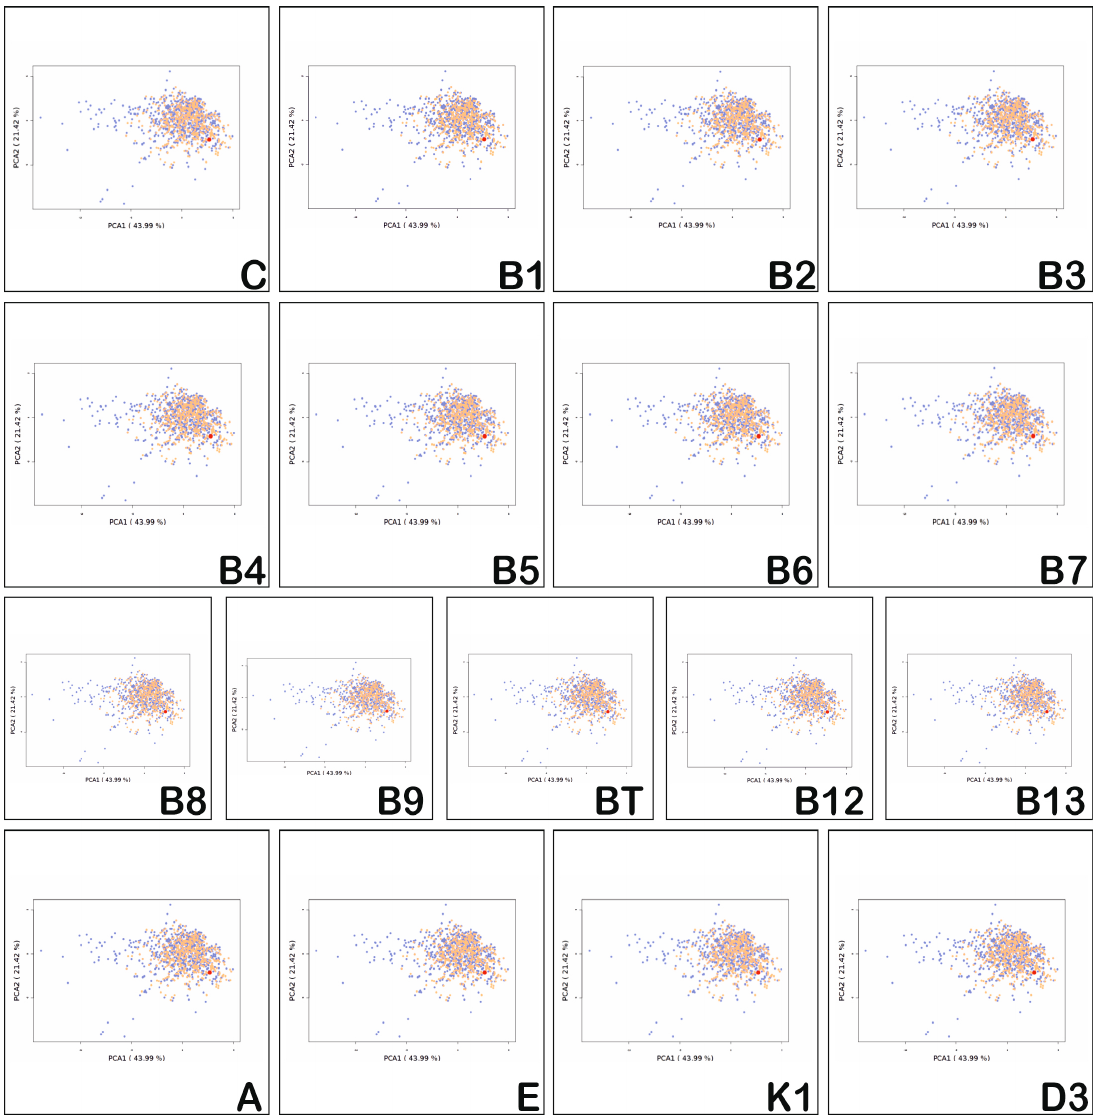
Figure 4. Statistical analysis of the positioning of the properties of the hydro- and liposoluble vitamins (red point) against the properties of other drugs found in DrugBank (orange dots) and Edrugs (blue).